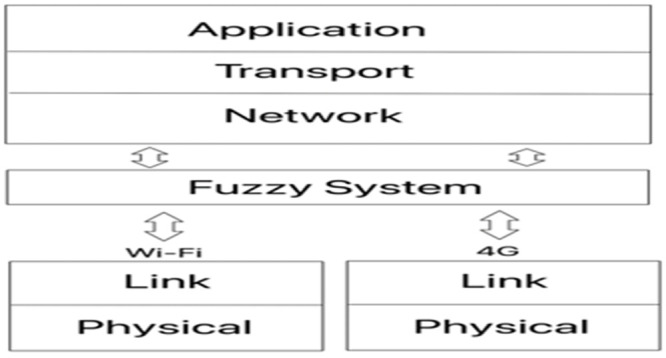
Fuzzy System layer.